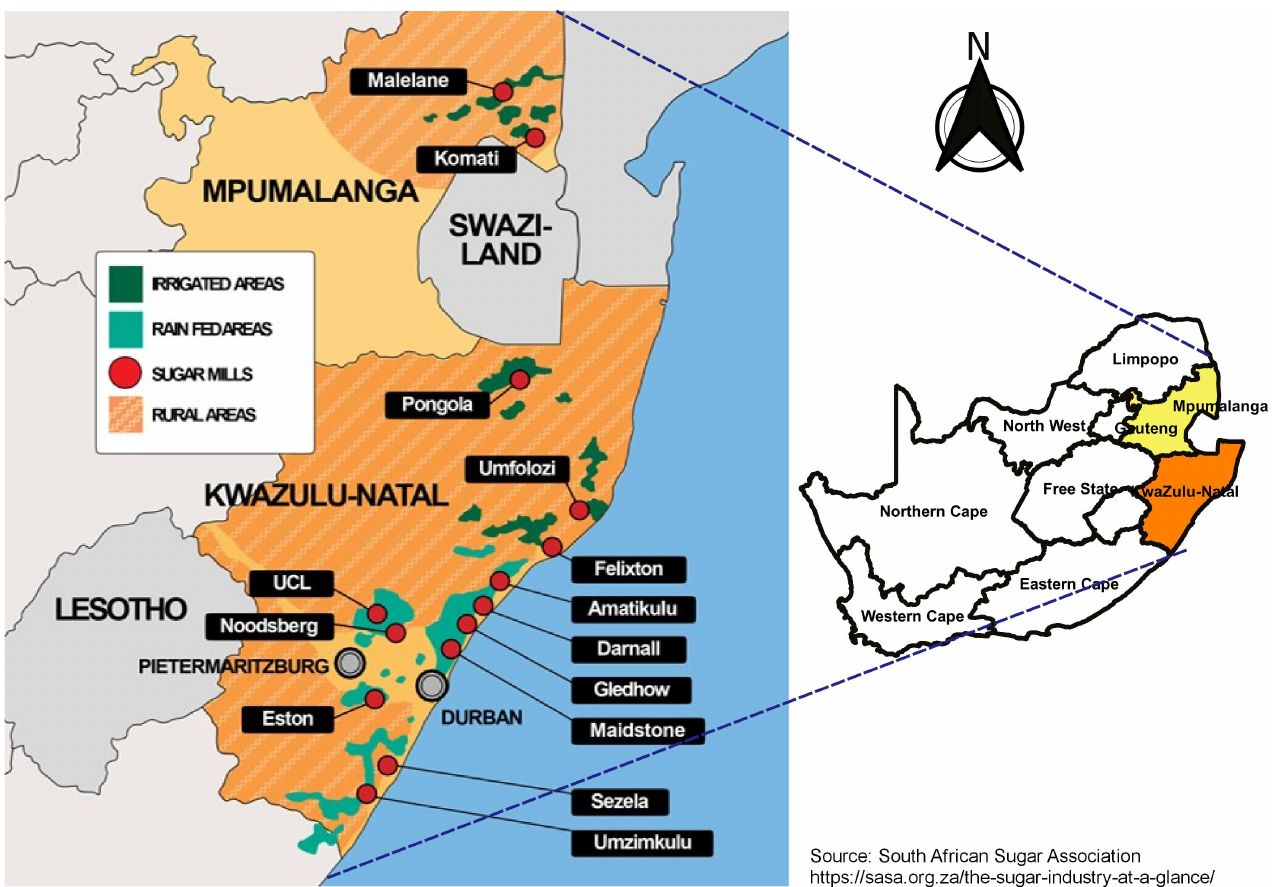
Figure 1. Sugarcane plantations regions in the Mpumalanga and KwaZulu-Natal provinces of South